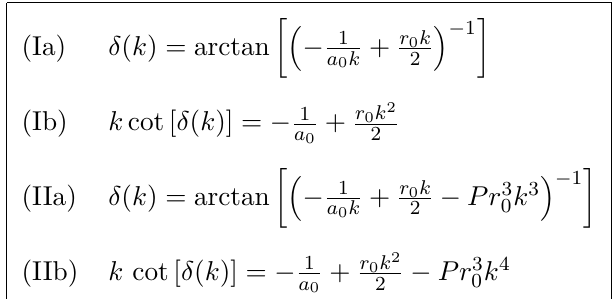
Table 2. S -wave phase-shift fit